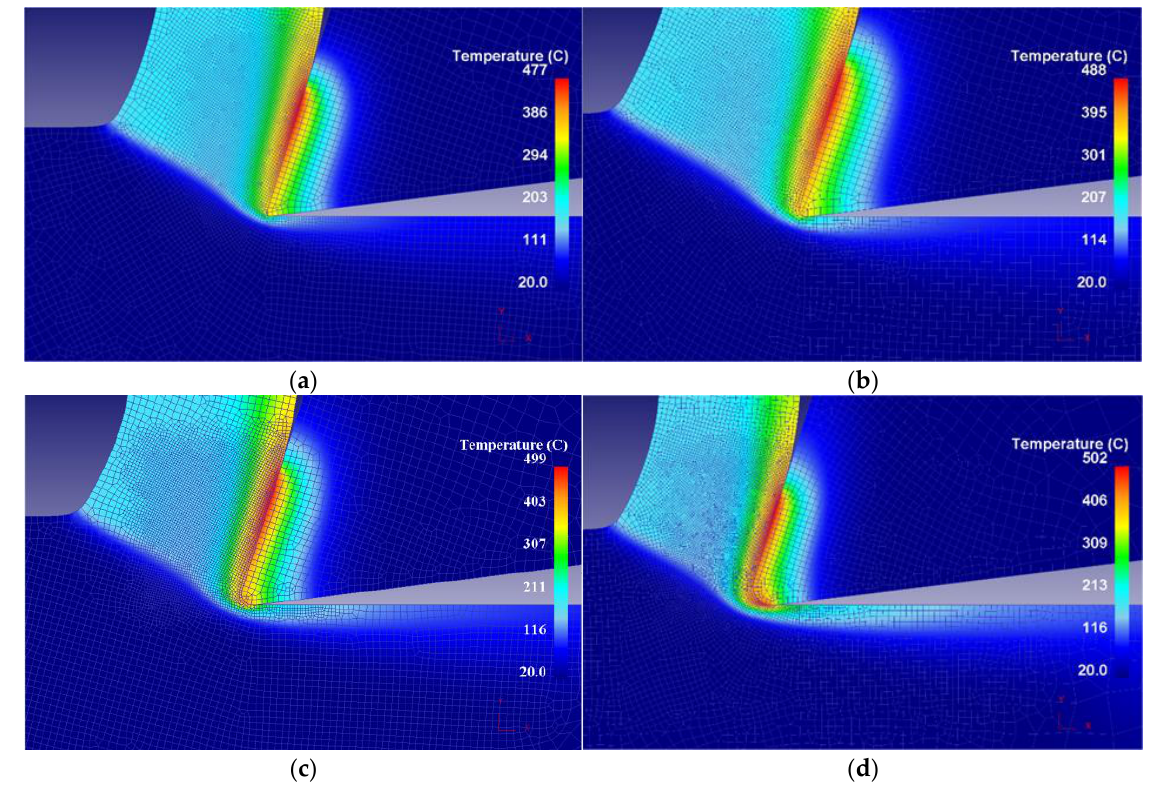
Figure 5. The distribution of cutting temperature in DEFORM™ at various edge radius for. α = 7 ◦ , γ = 17.5 ◦ : ( a ) 5 µ m, ( b ) 10 µ m, ( c ) 20 µ m, and ( d ) 40 µ m.